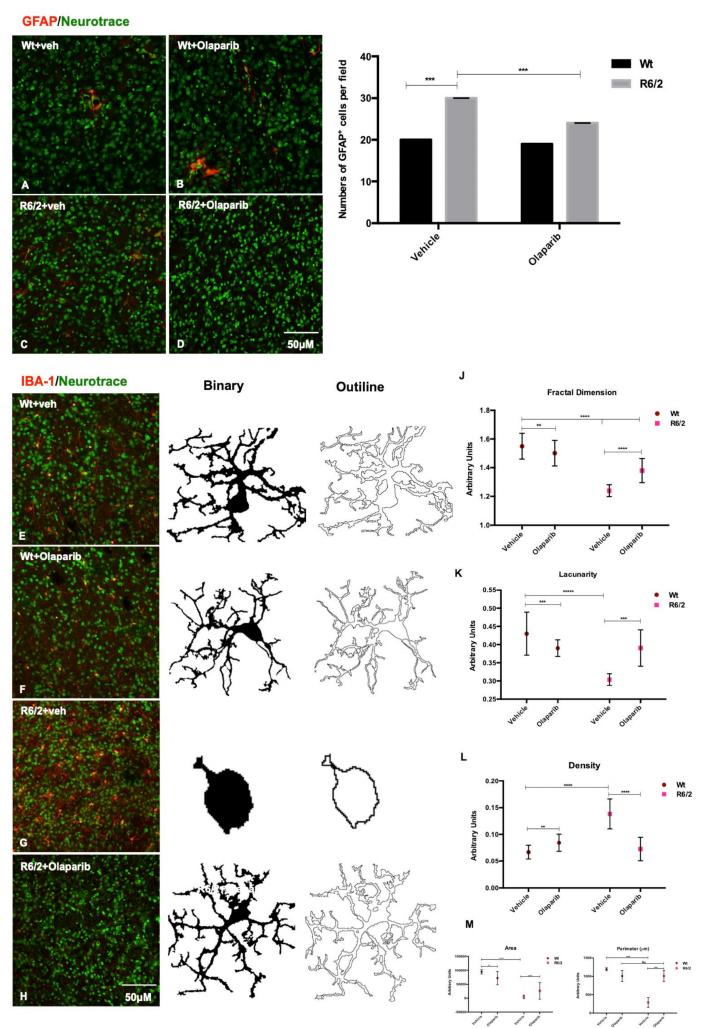
Figure 6. Olaparib reduces astrogliosis and microglial activation. ( A – D ) Representative confocal images showing the distribution of GFAP in the four experimental groups. Significantly lower GFAP positive cells were recorded in the Olaparib-treated R6 / 2 mice with respect to that of the saline-treated mice (F 1,76 = 68008 p < 0.001). ( E – H ) Analyzed collected data revealed a significant reduction of microglia positive cells in the R6 / 2 mice treated with Olaparib compared to that in the saline-treated R6 / 2 mice. ( J – M ) The morphological parameters of fractal dimension, lacunarity, density, cell area, and perimeter revealed the statistically significant reduced microglial activation in the Olaparib-treated R6 / 2 mice. A reduced, activated microglia was evidenced by higher fractal dimension and lacunarity, indicating the increase of branch complexity and heterogeneity, and lower density, which implies a more compact shape and lower cell area and